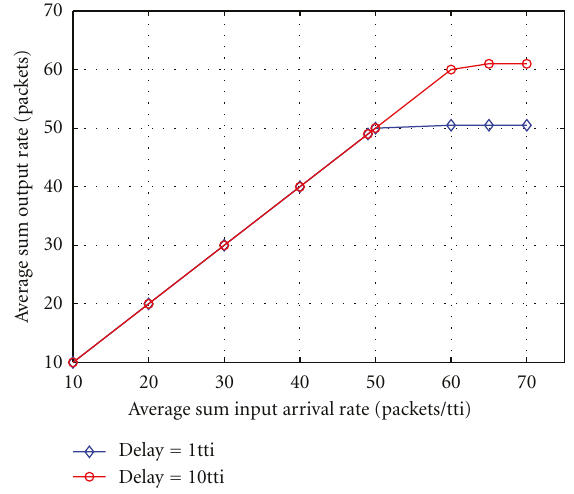
Figure 6: Percentage of packets with delay deadline violations for all user versus delay constraint achievement probability. Users = 14, Subcarriers = 40, Input arrival rate = 6 packets/tti, Cell Radius = 700m,and tti = 1ms.